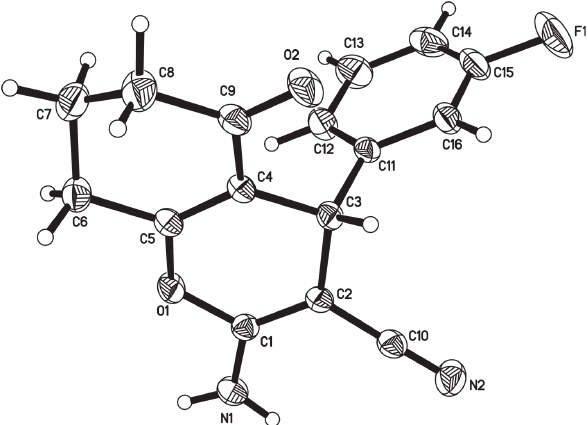
Table 2: Fractional atomic coordinates and isotropic or equivalent isotropic displacement parameters (Å 2